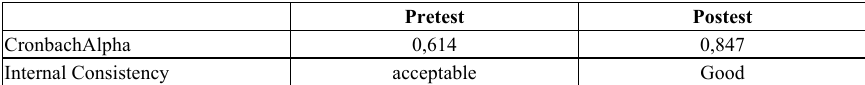
Table 6. Pretest and Post-Test Material Reliability